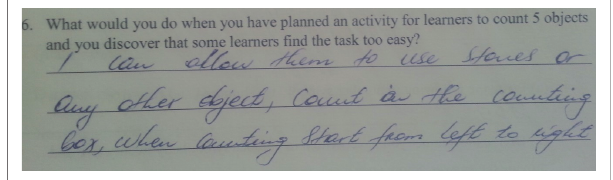
FIGURE 10: Response of Teacher 10.